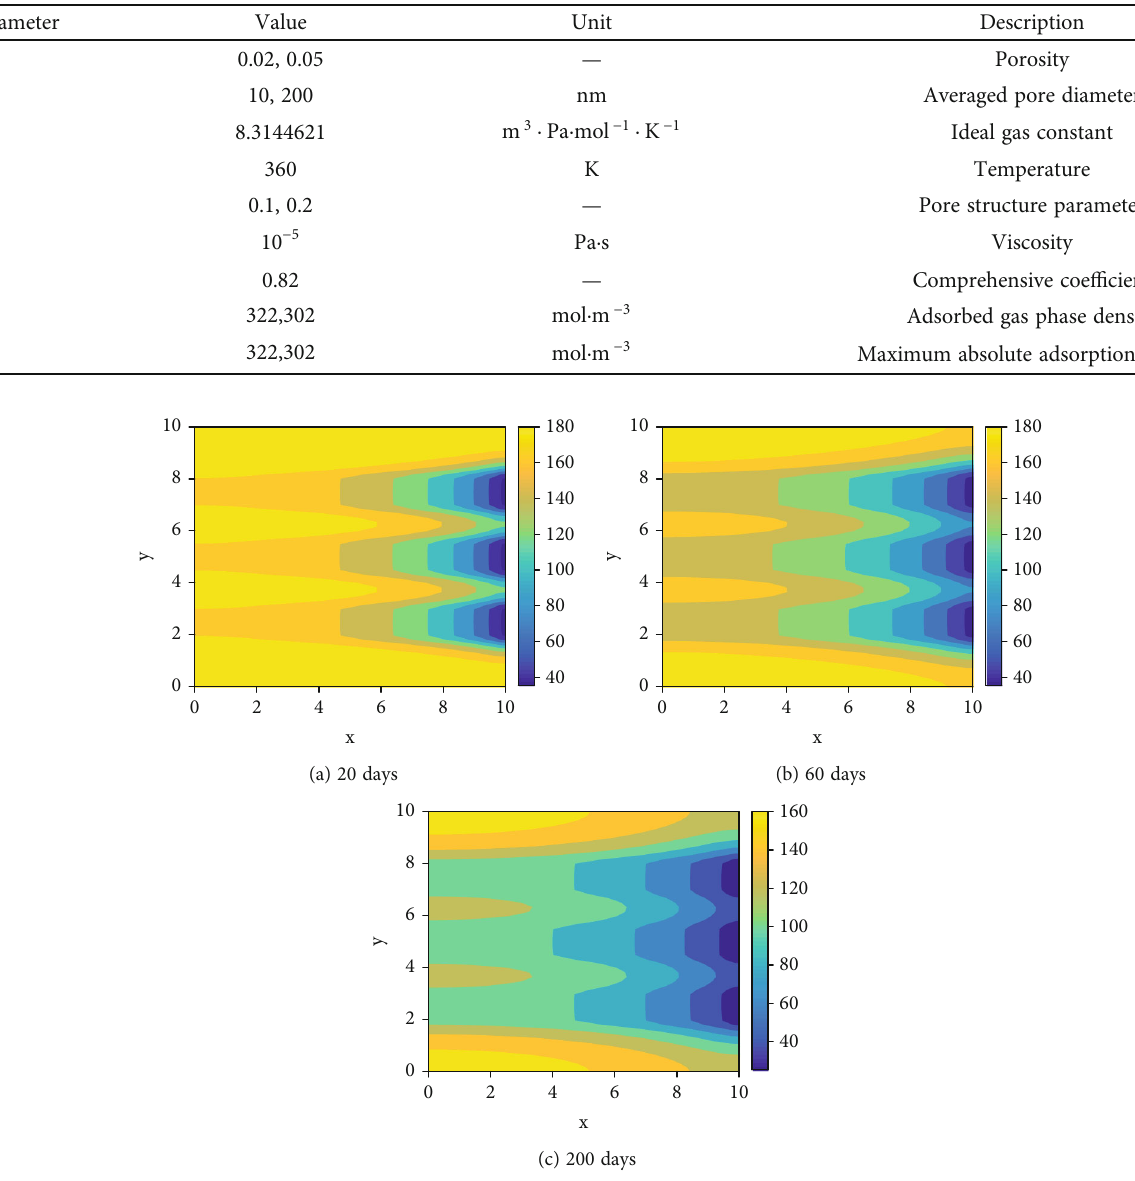
= 20 mol/m 3 at di ff erent b